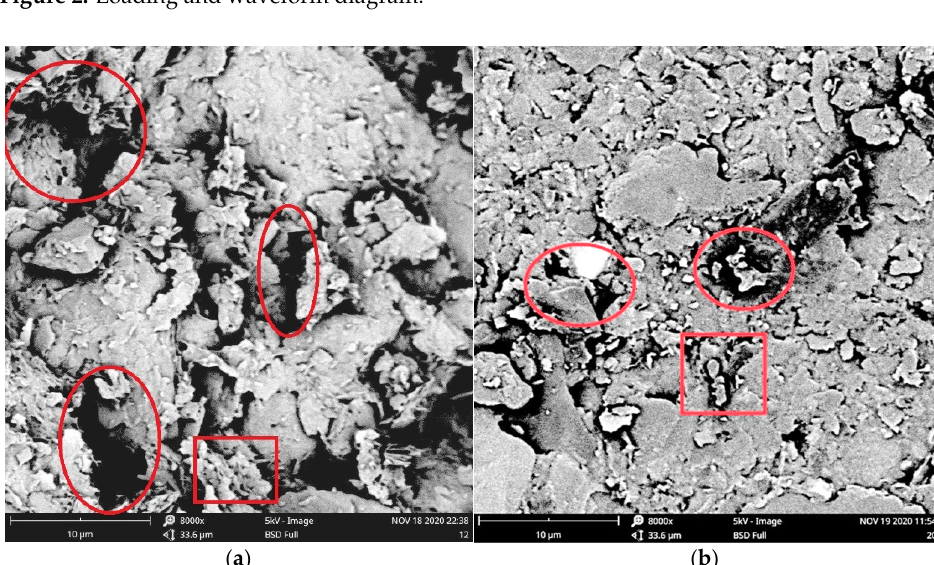
Figure 3. Microscopic scanning images before and after loading [16]: ( a ) before loading; ( b ) after loading. OCR = 9 identifications of porosity units. (The circle was marked as a pore, and the square was marked as a flocculent structure).